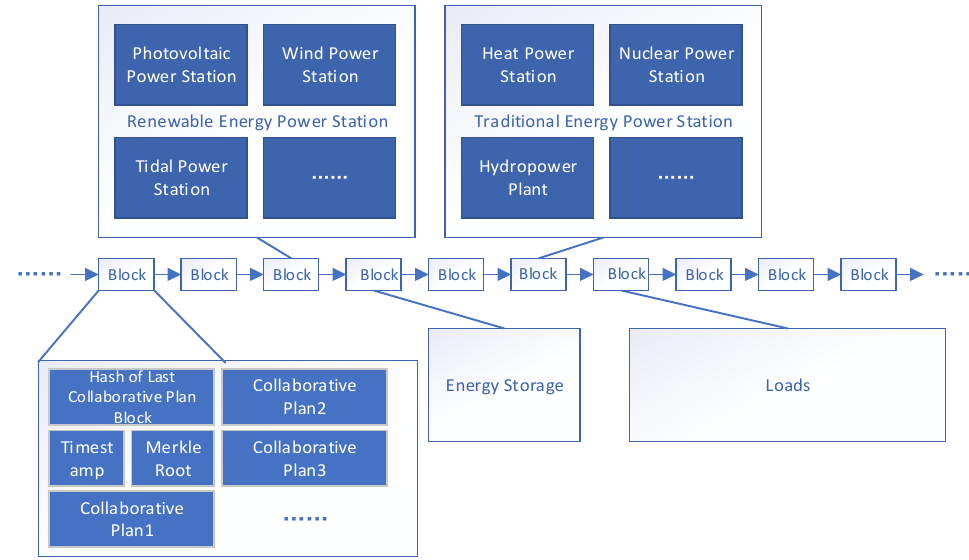
Figure 3. VPPBN structure.